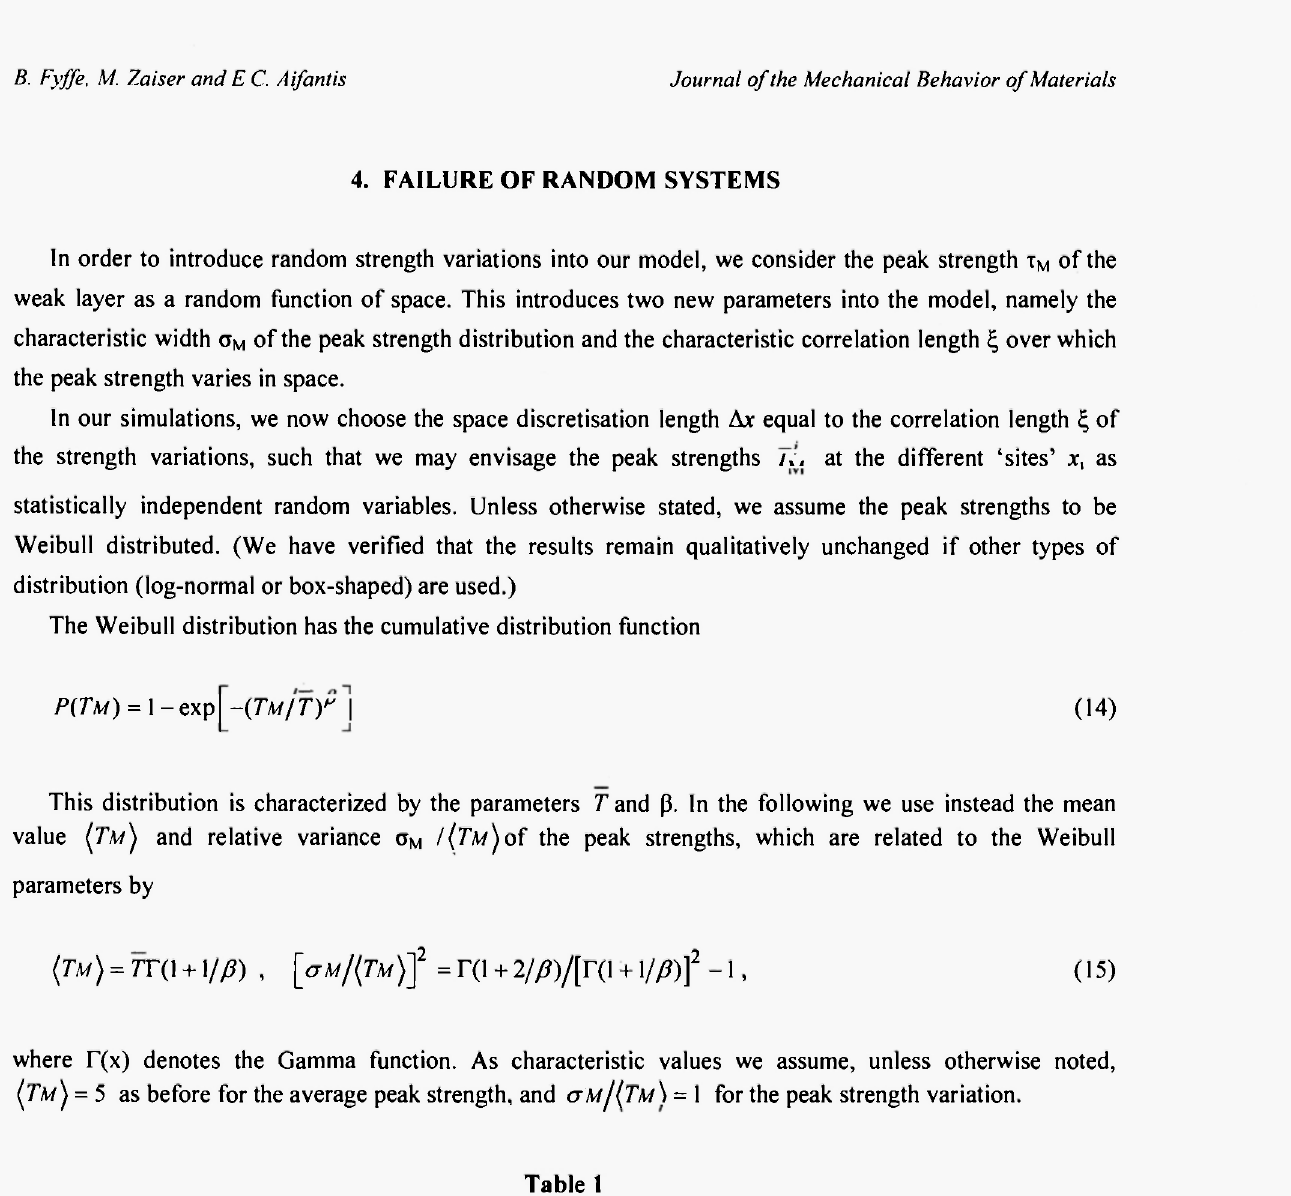
Typical values and ranges of the physical parameters in case of snow slab